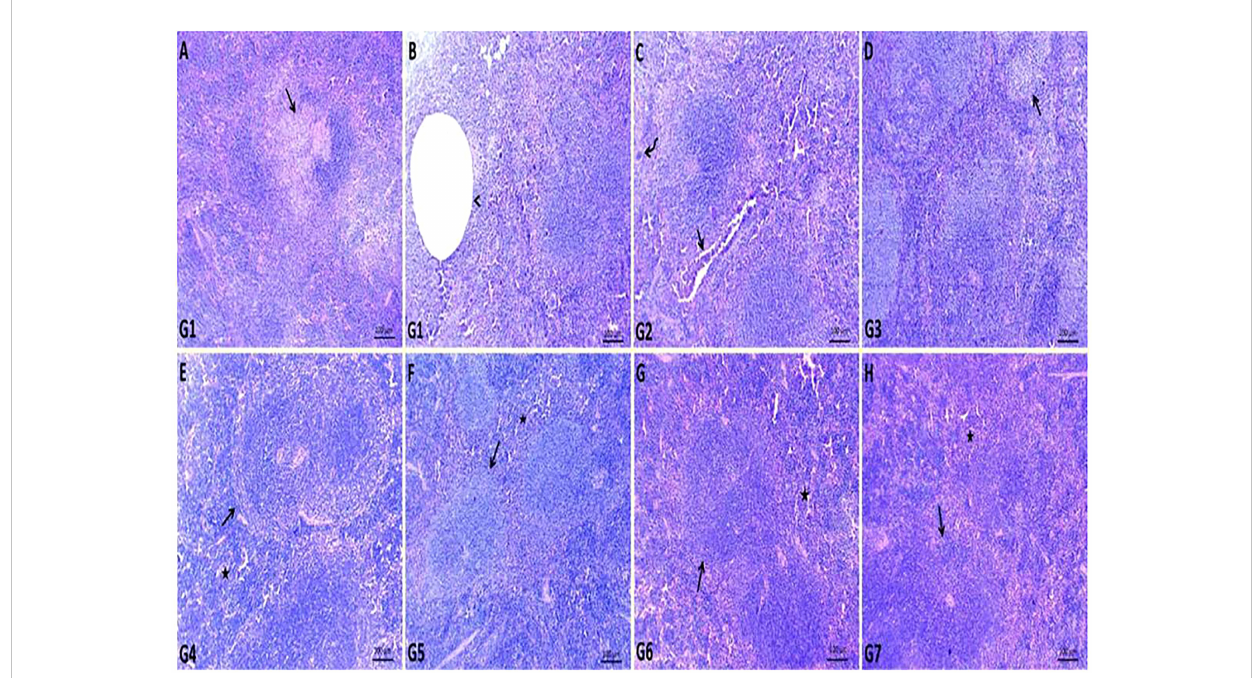
FIGURE 3 Representative photomicrographs of spleen sections of different groups in S. aureus mouse model. (A, B) : replaced number of white pulp either by necrotic materials (arrow) or cystic formation (arrow head) surrounded by necrotic debris in control positive group (G1), (C) : relatively normal white pulp with presence of large number of megakaryocytes (curved arrow) within red pulp and heavy in fi ltrated neutrophil, lymphocyte, macrophage within dilated splenic sinusoids and splenic blood vessels (arrow) in gentamicin treated group (G2), (D) : normal white and red pulp with presence of some mildly depleted white pulp (arrow) in ursolic acid methyl ester-treated group (G3), (E) : normal splenic white (arrow) and red pulp (star) in saline control negative group (G4), (F) : normal histomorphology of white pulp lymphoid zones (arrow) and red pulp (star) with splenic sinusoids in tween- 20 control negative group (G5), (G) : mildly activated most of white pulp cells (arrow) and moderately in fi ltrated red pulp with hematopoietic elements (star) in ursolic acid methyl ester control negative group (G6), (H) : normal cytomorphology of germinal, mantle and marginal zones of white pulp (arrow) and in fi ltrated red pulp by large number of lymphocyte, neutrophils, and macrophages (star) in gentamicin control negative group (G7). H&E, scale bar 100 m